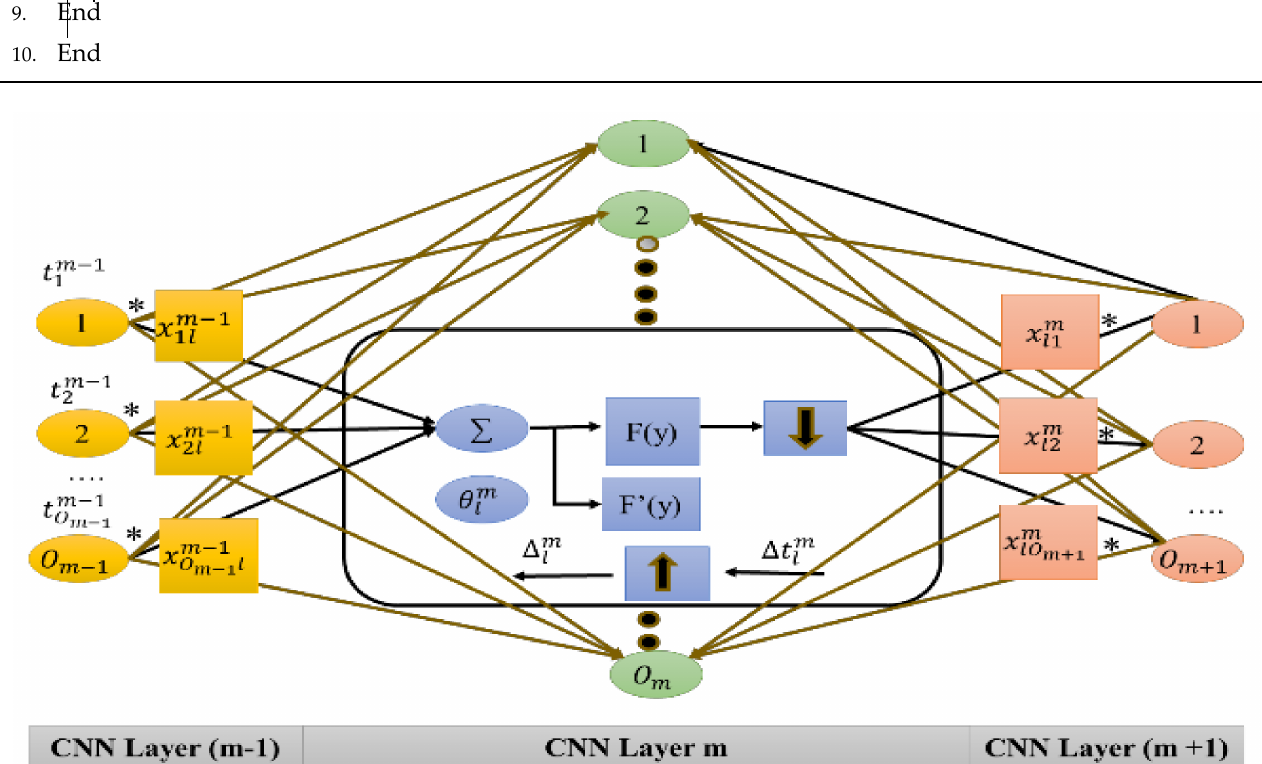
Figure 3. Backward and forward propagation in the one-dimensional convolutional neural network (ODCNN). Where * represents the product function during forward and backward propagation